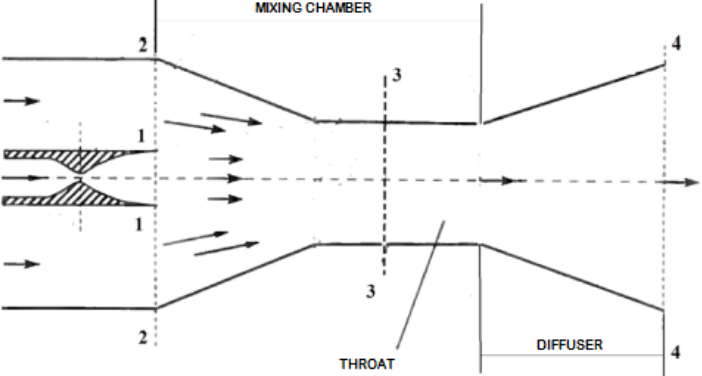
Figure 1. Ejector design [25]: 1—a high-pressure flow nozzle; 2—a low-pressure flow nozzle; 3—a mixing chamber; 4—a diffuser.